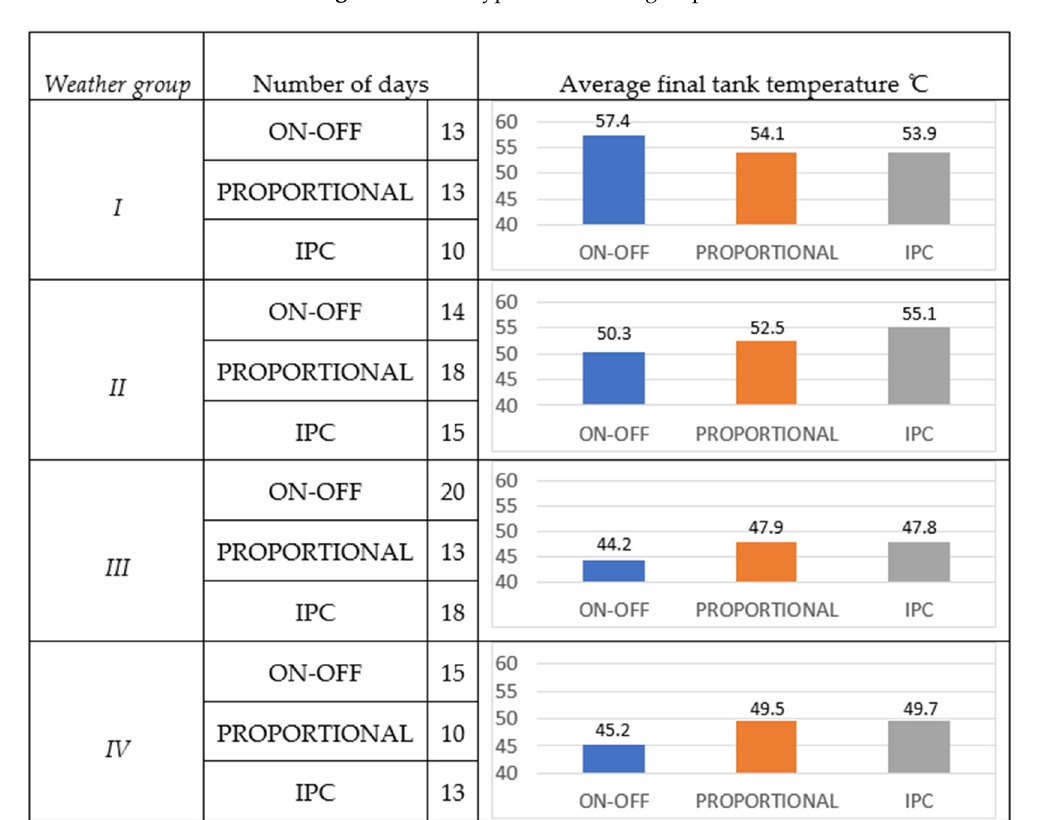
Figure 14. Summary of measurement data.